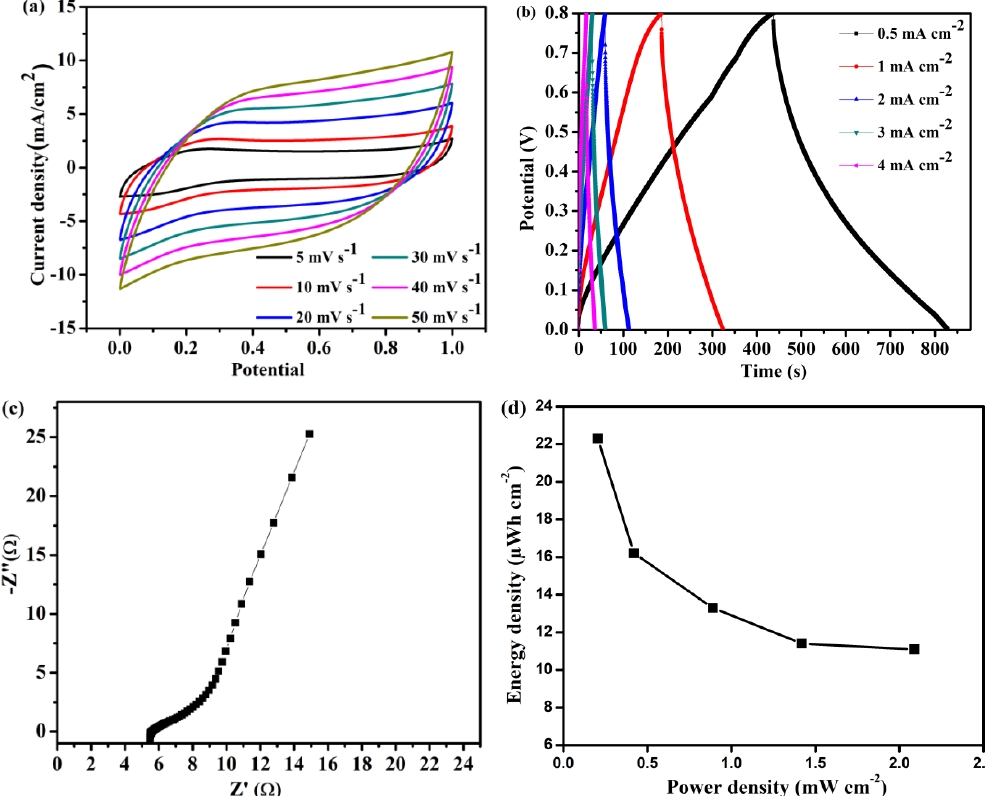
Figure 7. ( a ) CV curves recorded at various scan rates, ( b ) GCD curves recorded at various current densities, ( c ) Nyquist plots recorded over the frequency range from 0.01 Hz to 100 kHz, and ( d ) Ragone plot (power density vs. energy density) of the assembled all-solid-state symmetric SC.